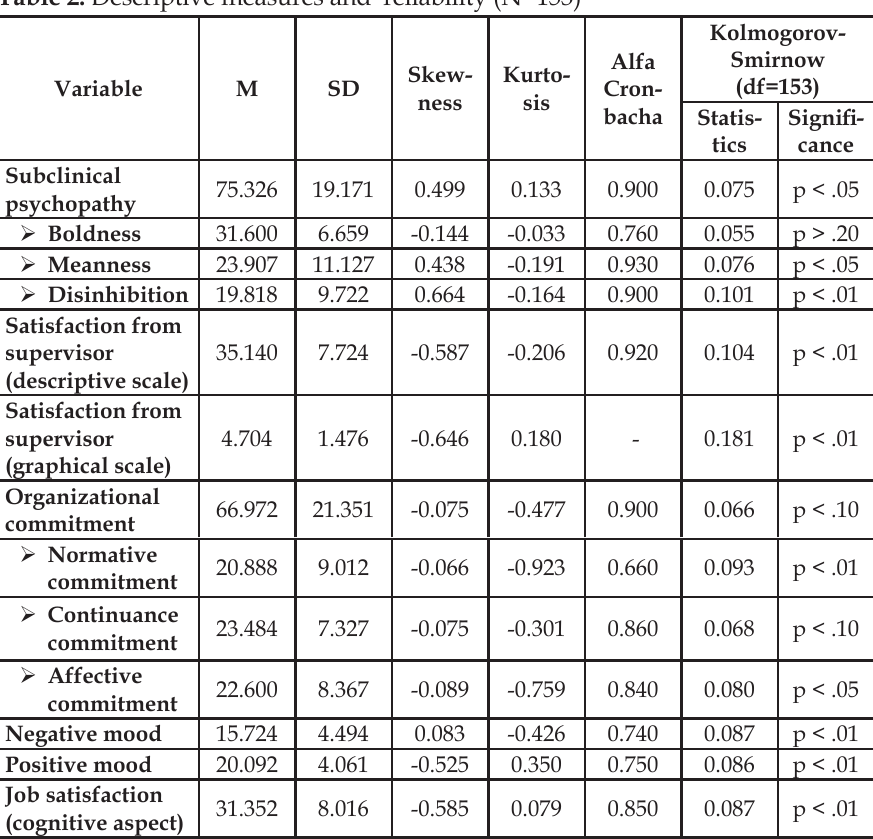
Table 2. Descriptive measures and reliability